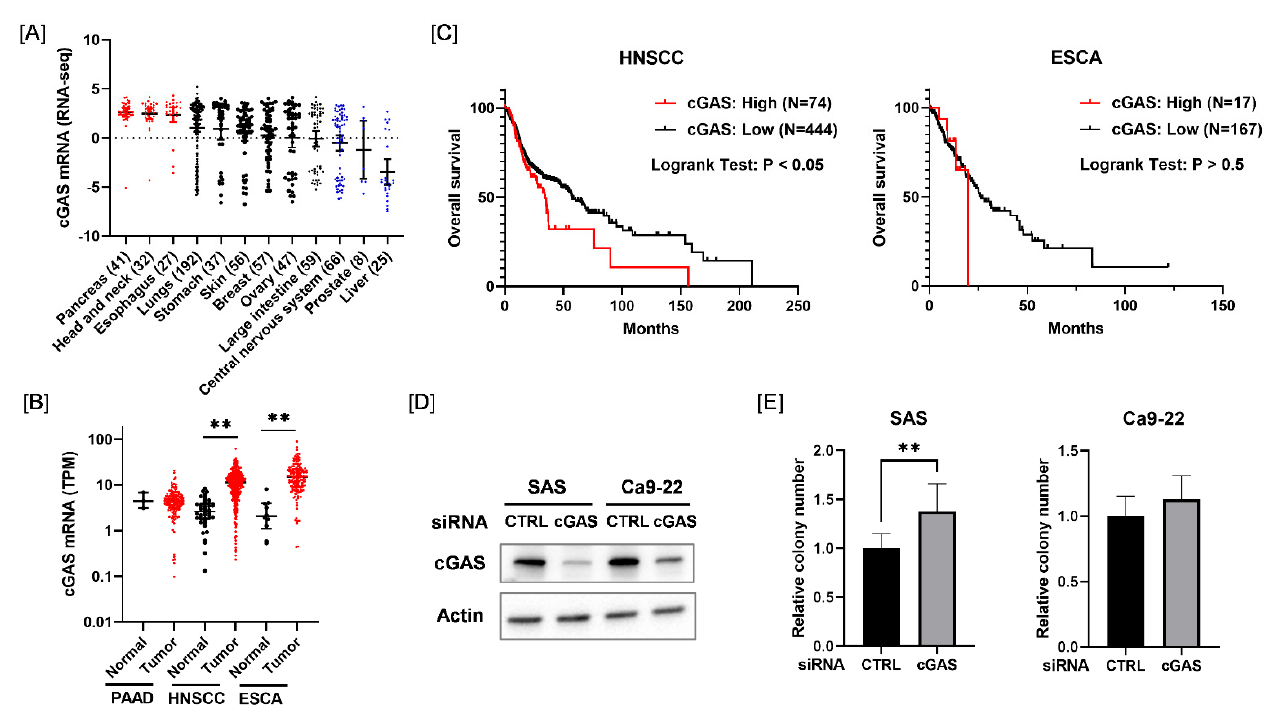
Figure 1. Relationship between the expression of cGAS mRNA and survival in each disease. ( A ) Expression levels of cGAS mRNA in each solid tumor cell line. ( B ) Black and red symbols indicate cGAS expression levels in adjacent normal tissues and tumor tissues, respectively. PAAD, pancreatic adenocarcinoma; HNSCC, head and neck squamous cell carcinoma; ESCA, esophageal carcinoma. ( C ) Relationship between the expression level of cGAS and patients’ overall survival. High cGAS expression was associated with poor overall survival of HNSCC patients in the TCGA cohorts. ( D ) HNSCC cells (SAS and Ca9-22) transfected with the control or cGAS siRNA were harvested, and cGAS protein expression was analyzed using western blotting. A representative image of an immunoblot is shown. Actin was used as the loading control. ( E ) The proliferative ability of cGAS knockdown cells was assessed by colony formation assay. ** indicates p < 0.01.